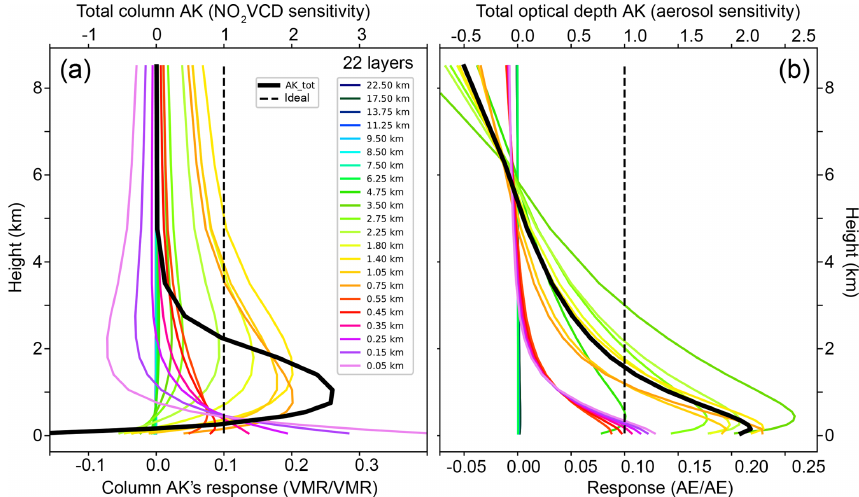
Figure 4. Averaging kernel columns: (a) in VMR representation for NO 2 profile retrieval and (b) in the corresponding intensive quantity for the aerosol extinction (AE) profile. Each colored line shows the expected response on perturbation in a certain layer and belongs to the lower axis. The total column averaging kernel, (a) for the NO 2 VCD and (b) for the total optical depth, is given as a black line and belongs to the upper axis. The vertical dashed line in each panel indicates an ideal sensitivity of 1.0 at all altitudes.